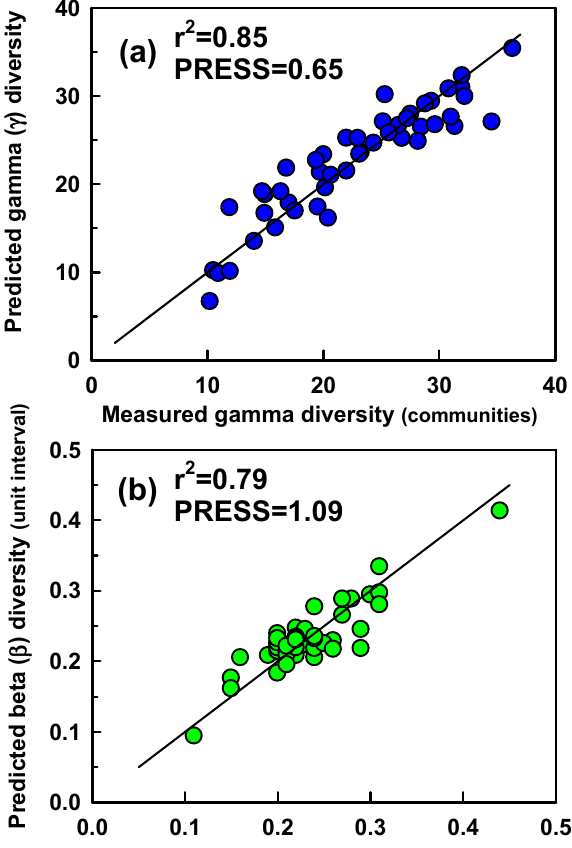
Figure 6. Relationships between measured diversity of grassland communities and diversity predicted from spatial heterogeneity in brightness normalized values of canopy reflectance using PLSR: ( a ) γ and ( b ) unit interval of β diversity ( β 0–1 ) of grassland communities created by randomly-selecting between 4 and 40 patches. PLSR explained 85% and 79% of the variance in γ diversity and β 0-1 , respectively (n = 47; root mean predicted residual sum of squares, PRESS = 0.65 and 1.09, respectively). Lines show the 1:1 relationship with measured diversity. Shannon β diversity ranged from 2.7 to 1.9 and is inversely correlated to β 0–1 .